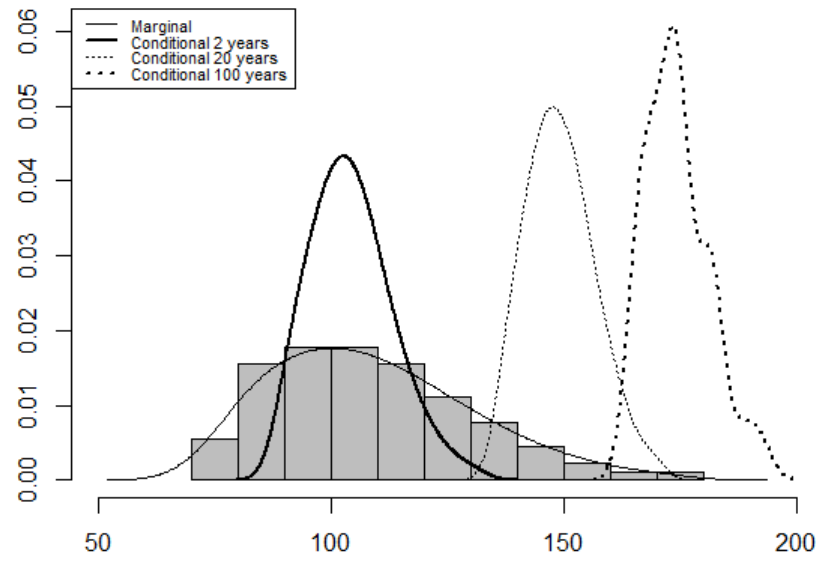
Figure 9. Conditional quantiles of the volume (1000 m 3 ) in station 15 according to the variations in probabilities with fixed